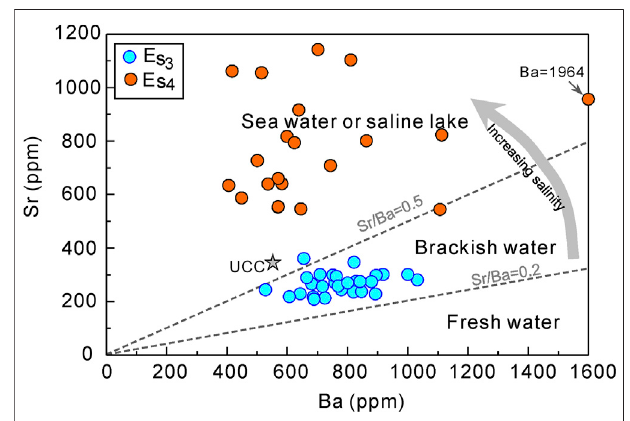
FIGURE 8 | Variations of elements Sr and Ba show salinity in the Es source rocks in the Langgu sag.